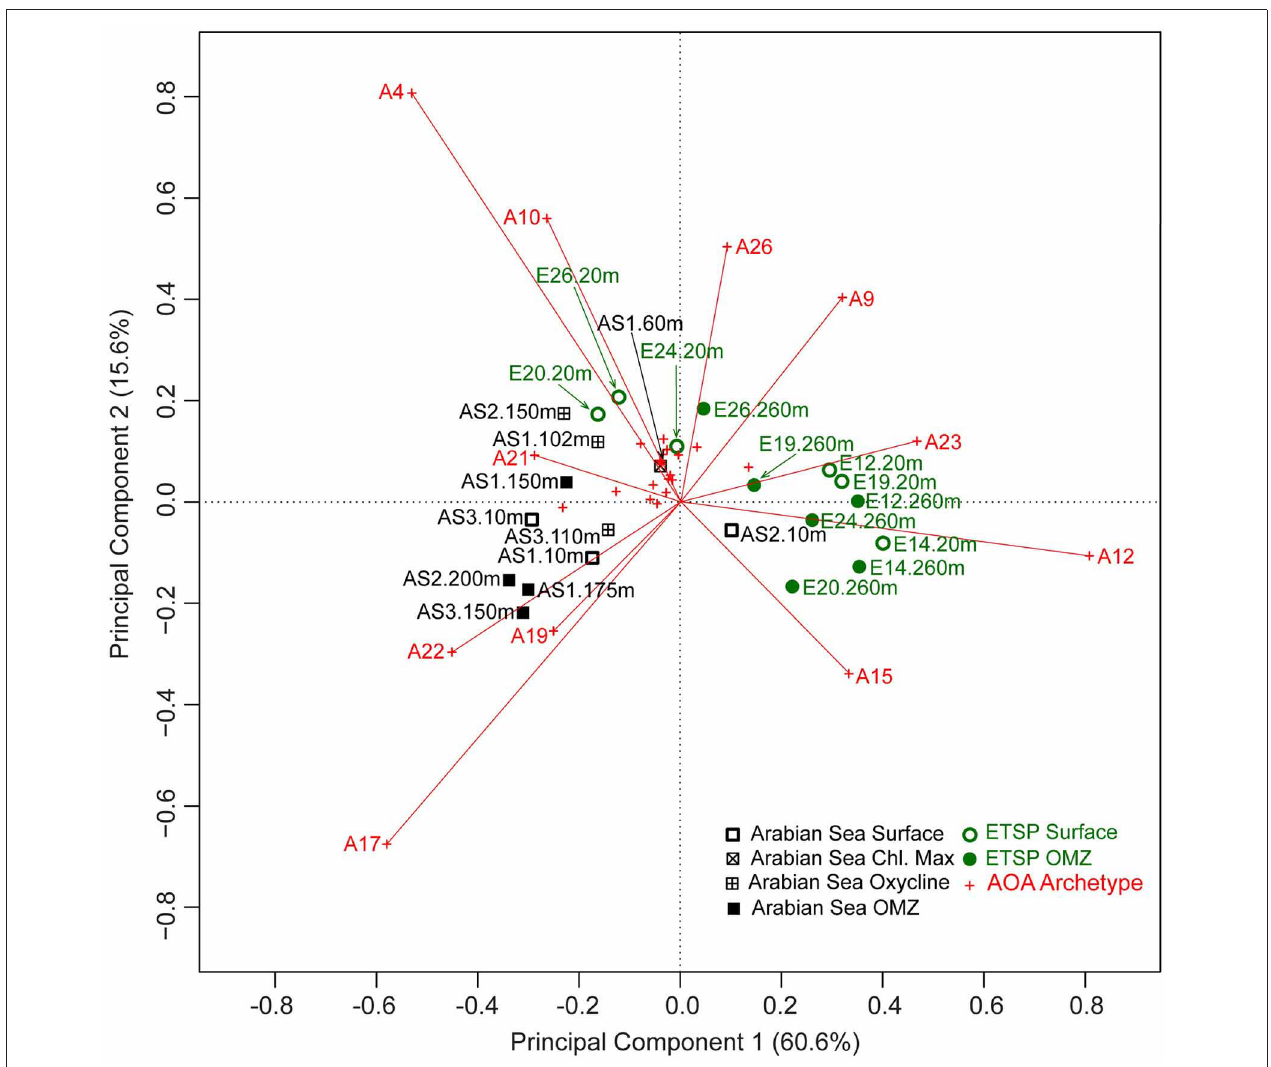
FIGURE 3 | Distance biplot of principal component analysis (PCA) on AOA community composition from the Arabian Sea and the ETSP using chord distance. Each AOA archetype is shown as a red cross. AOA archetypes that had a relatively high contribution to the two principal components plotted were highlighted by labeling them with “A archetype number,” and drawing the vector between the origin and the AOA archetype. Circles represent samples from the ETSP (E), and squares represent samples